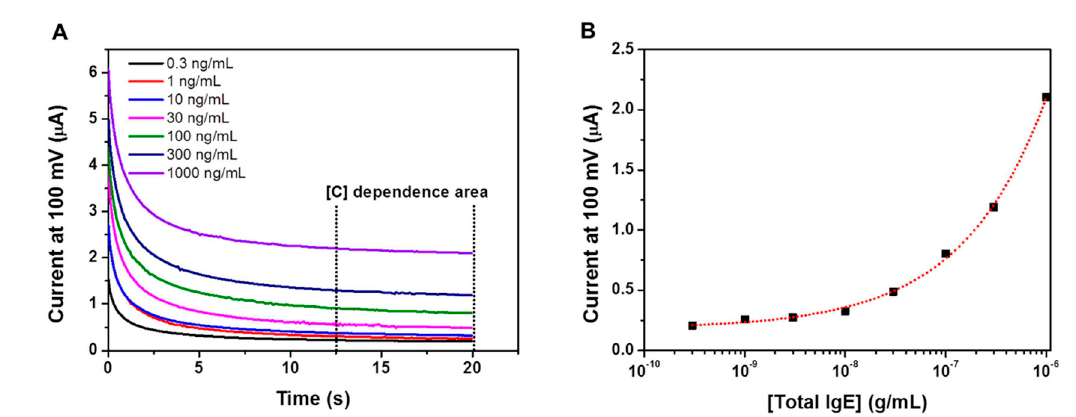
Figure 2. ( A ) Amperometry measurement of the EC sensor at 100 mV for different IgE concentrations. ( B ) EC calibration curve for IgE obtained from IgE solution in mouse